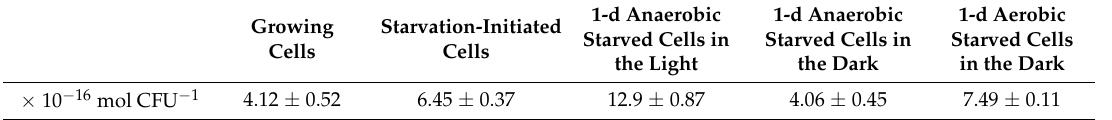
Table 1. Cellular ATP